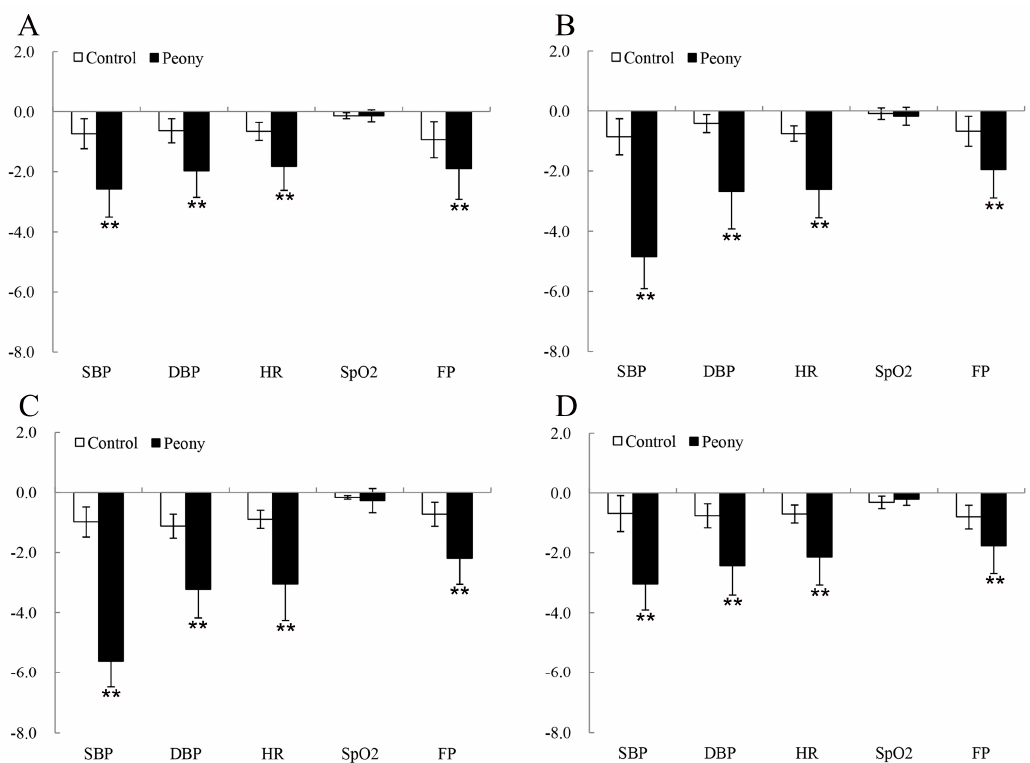
Figure 4. The pre- and post-viewing changes of participants’ physiological indices in the experimental (peony) and control groups at ( A ) ELS (exhibition leaf stage), ( B ) IBS (initial bloom stage), ( C ) FBS (full bloom stage), and ( D ) TBS (terminal bloom stage). SBP: systolic blood pressure, DBP: diastolic blood pressure, HR: heart rate, SpO 2 : blood oxygen saturation, and FP: fingertip pulse. N = 74, mean ± SD. ** p < 0.01, paired-sample t -test.